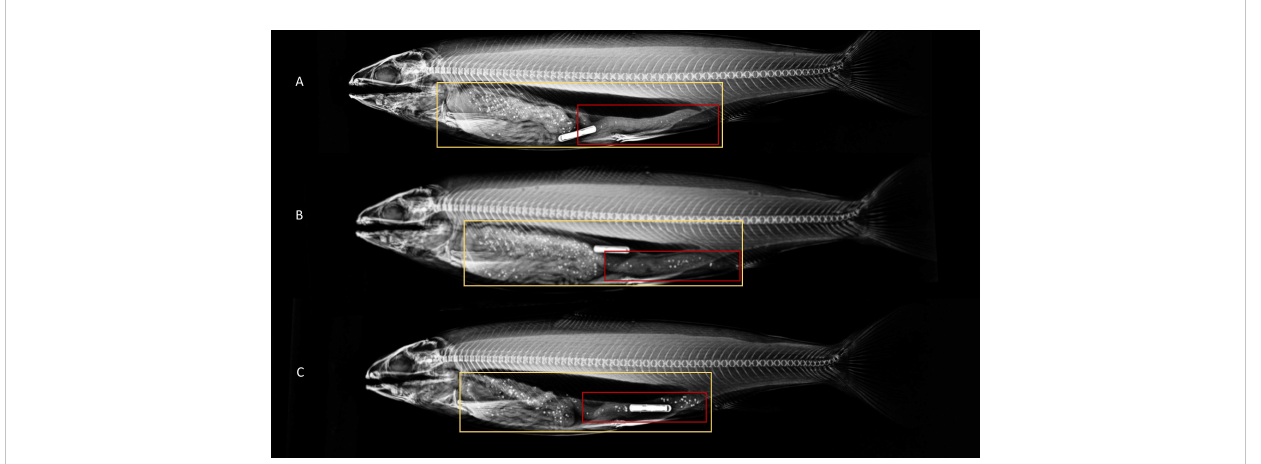
FIGURE 4 X-ray images of Atlantic salmon with regions of interest selected for entire gastrointestinal tract (yellow), and distal intestine (red) at differing times since fi rst being offered feed containing radio-opaque beads (A) 6.5 hours since being offered feed (B) 11 hours since fi rst being offered feed and (C) 27 hours since fi rst being offered feed. The image is altered to fi t all three radiographs in one